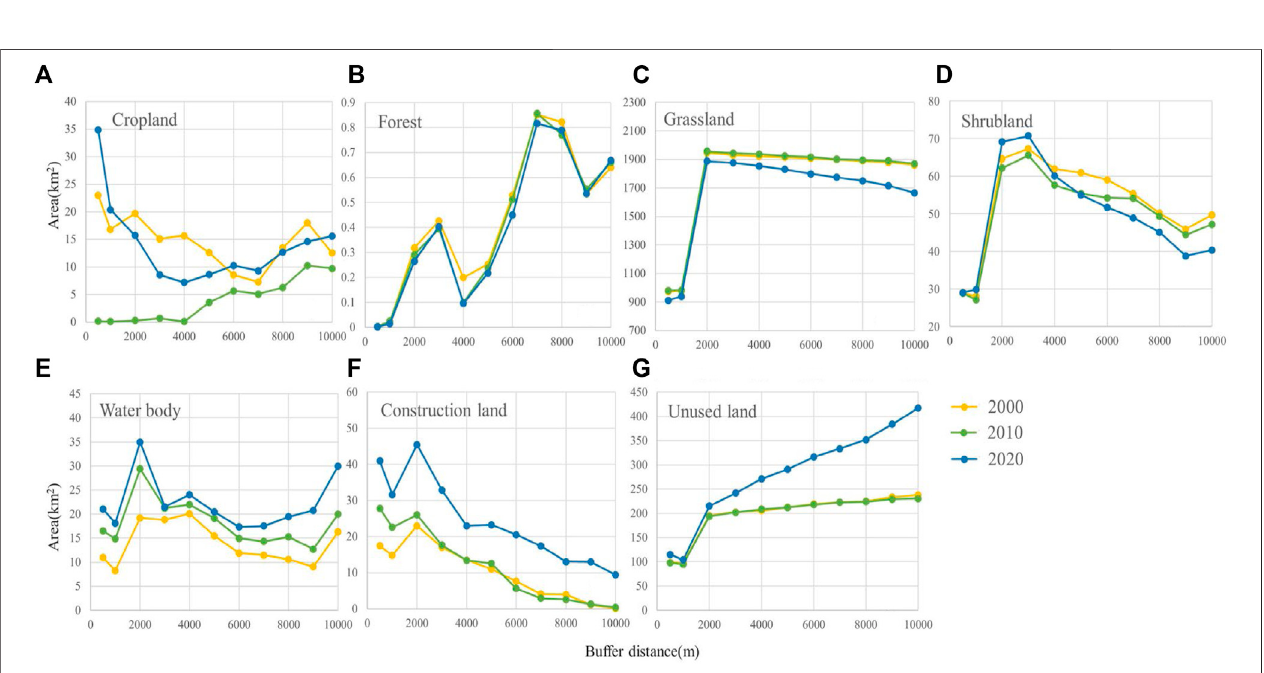
FIGURE 3 | (A) Cropland; (B) Forest; (C) Grassland; (D) Shrubland; (E) Water body; (F) Construction land; (G) Unused land.